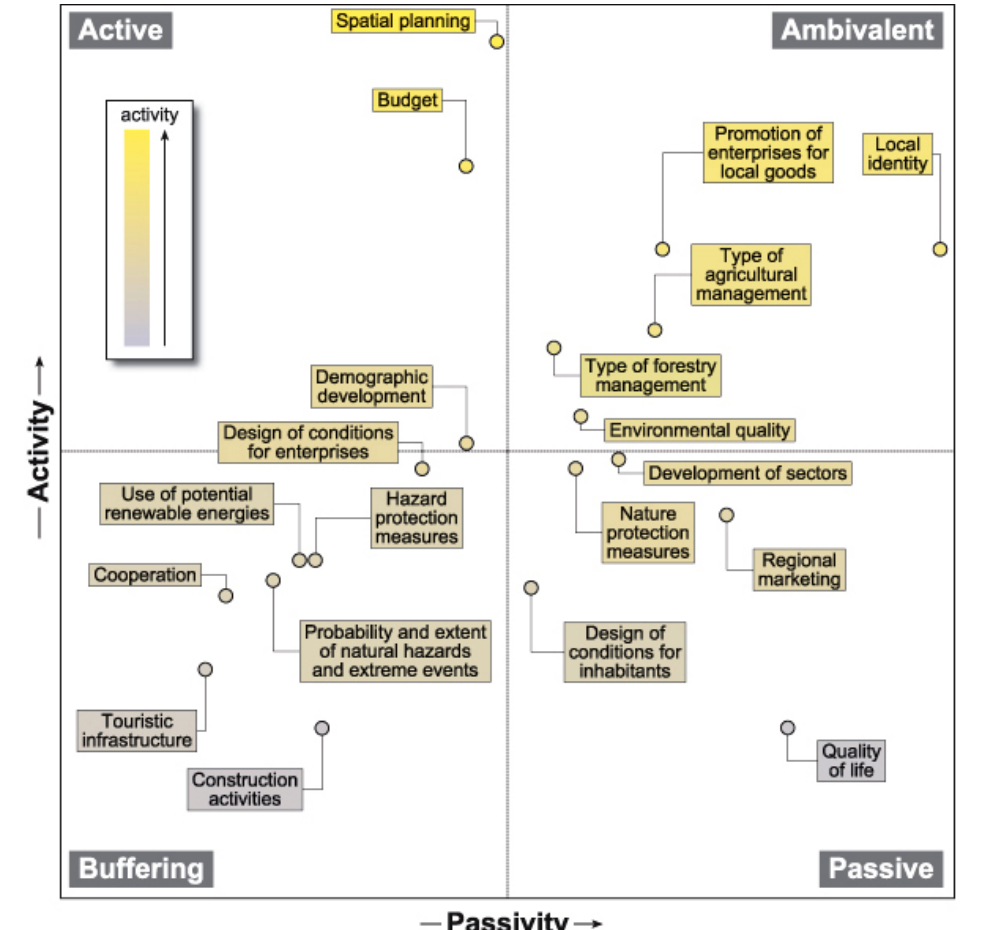
Fig. 5 . System grid showing the relative activity/passivity of the impact factors of the local scenarios as derived by the system analysis. The underlying values were omitted for simplicity. The activity and passivity ranks of local identity were three and one, respectively. Spatial planning ranked first for activity and 12 for